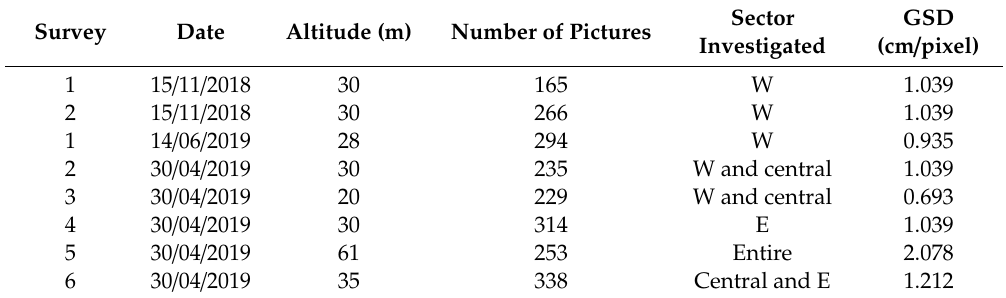
Table 1. Main characteristics of unmanned aerial vehicle (UAV) flights carried out in 2018 and 2019. Survey Altitude (m) Number of